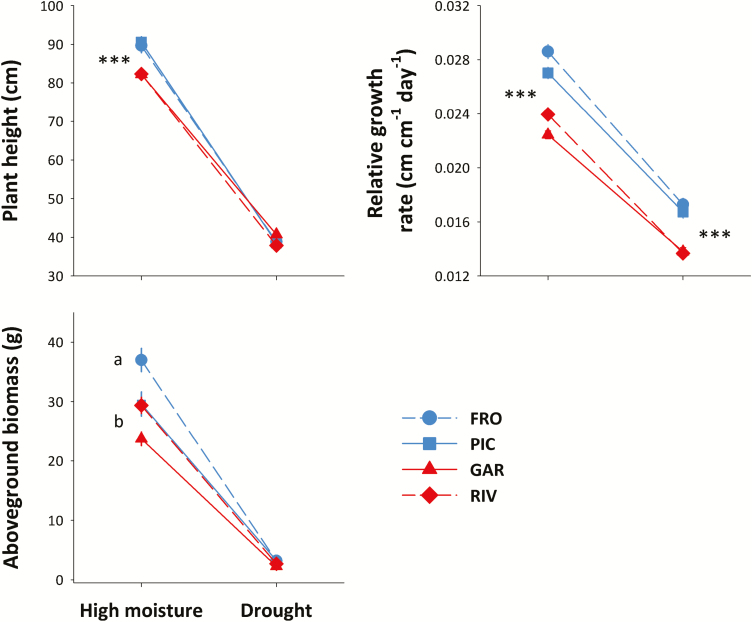
Population differences in growth traits in two contrasting water availability treatments. Each line shows the norm of reaction of each of two northern (blue) and two southern (red) populations for a given trait. Observed population means ± SE are shown for 21 families per population, with three replicates per family and treatment. Significant regional differences in each watering treatment are shown with asterisks (no asterisk: not significant differences; *P < 0.05; **P < 0.01; ***P < 0.001). Different letters indicate significant differences among populations in mean trait values within each watering treatment, according to Tukey post hoc tests. N = 504 plants for all traits. Population codes are those in Fig. 1.